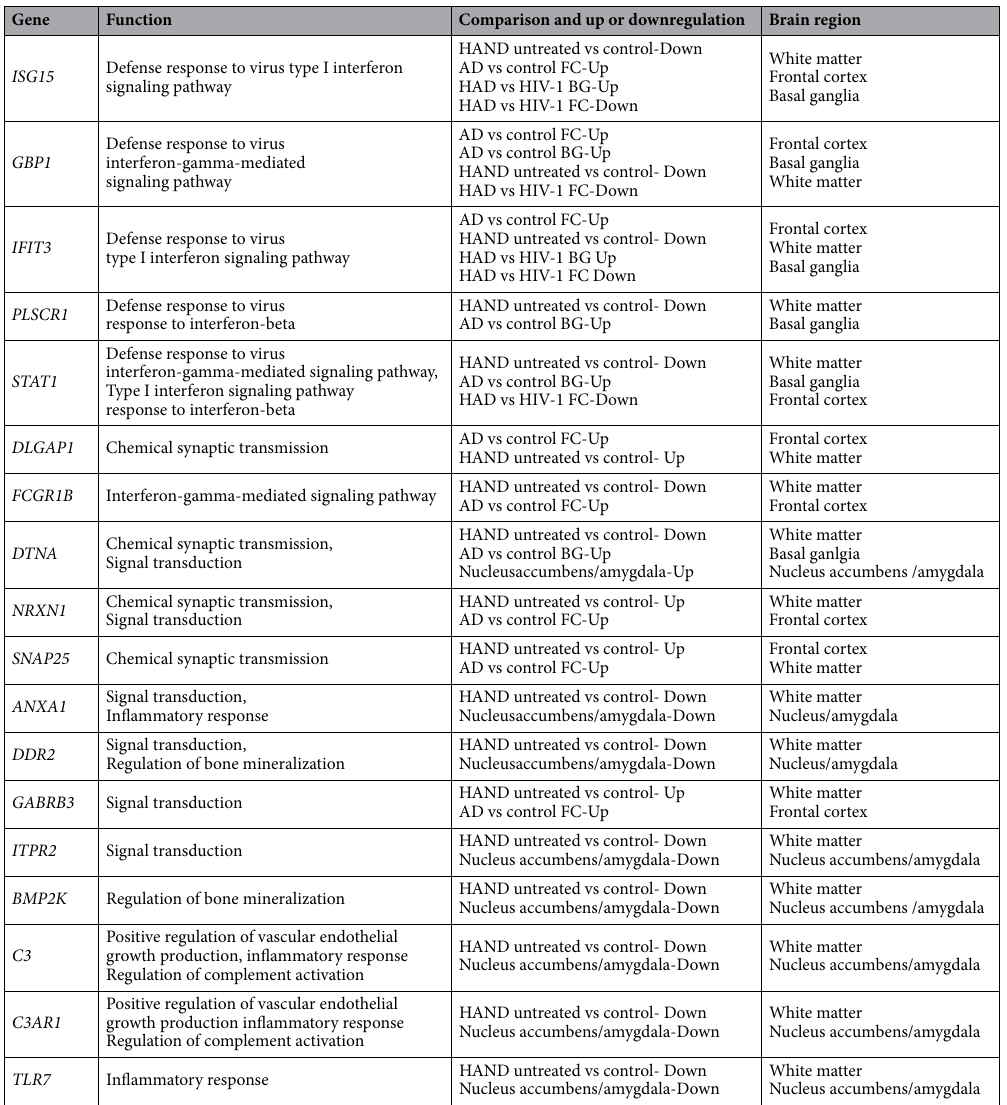
Table 2. Common differentially expressed genes between AD and HAND patients. This table summarizes the results from SAM analysis and Gene Ontology Analysis. The genes and the processes they are involved in are listed. The comparison column includes the comparison (HAND or AD) used for SAM analysis and whether they were up or downregulated. The specific region is represented by abbreviations (FC: frontal cortex, BG: basal ganglia, WM: white matter). Four mRNA transcripts were significantly differentially expressed between comparisons they are ISG15, GBP1, STAT1, and